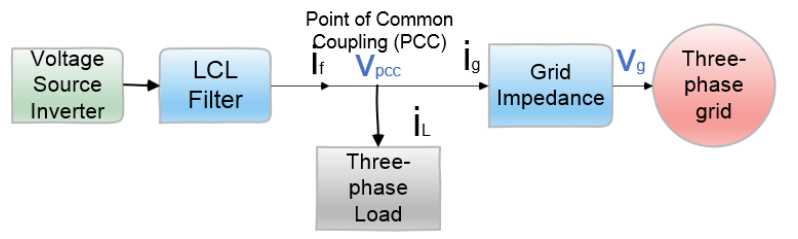
Figure 1. System block